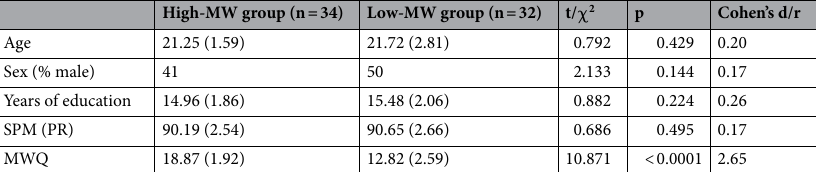
Table 1. Demographic and cognitive characteristics of two empirically-distinguished groups differing with regard to the level of dispositional MW. High-MW: a subgroup with higher MWQ total score, Low-MW: a subgroup with lower MWQ total